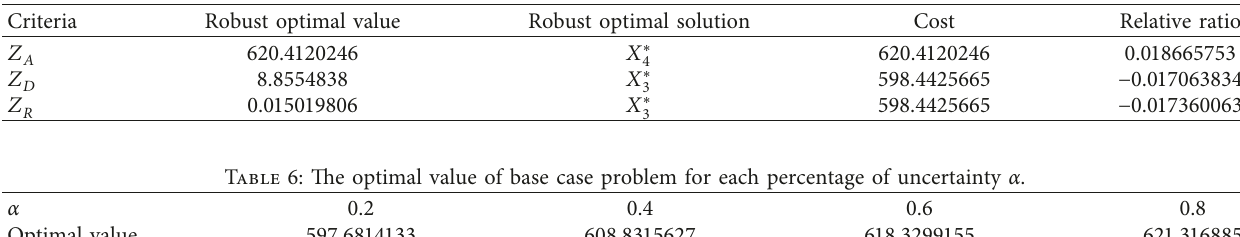
Table 5: The result of RVRPSTW.